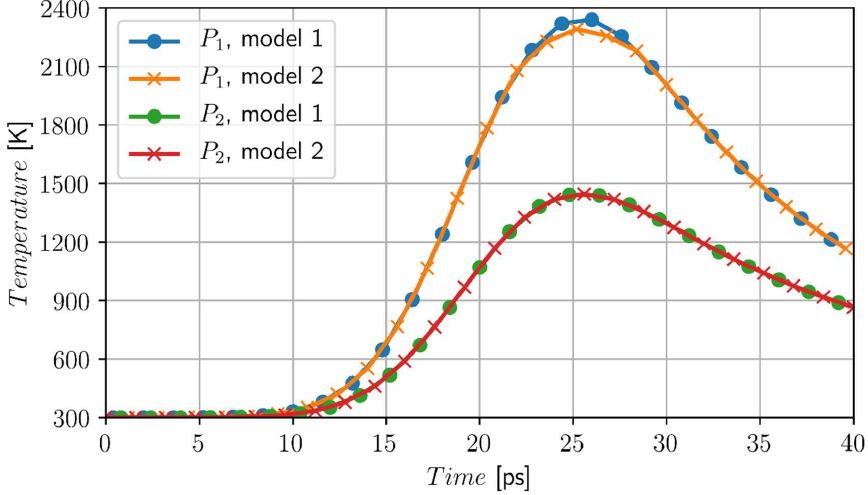
Figure 2. Temperature history at the points P 1 (0, 0) and P 2 (0, 20 nm), model 1—artificial mushy zone (∆ T = 3 K), model 2—melting at the constant temperature, chromium, I 0 = 1.6 × 10 4 J/m 2 , t p = 10 ps.